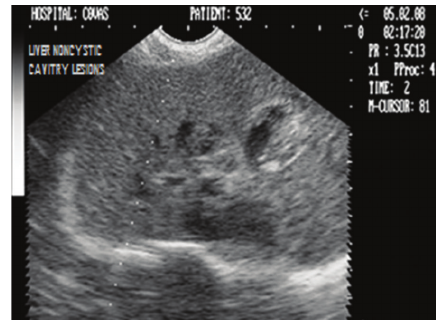
Figure 36: Laparoscopic direct visualization of liver in 5-year- old mixed-breed male dog showing a nodular hyperplasia which remained undetected